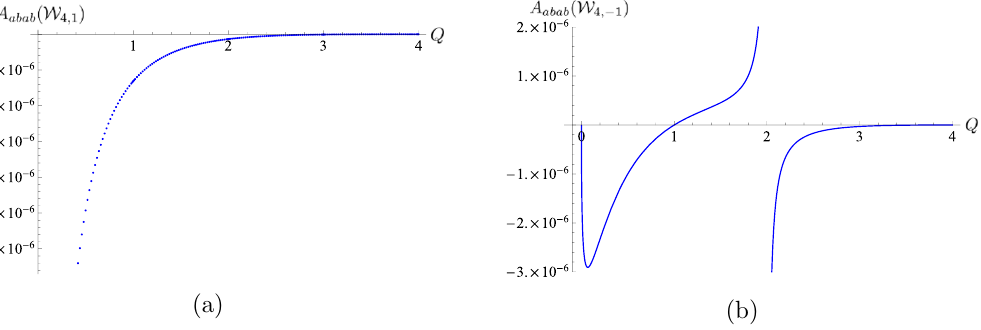
Figure 11 . The bootstrapped A abab ( W 4 , 1 ) on the left and the analytic A abab ( W 4 , − 1 ) on the right. The amplitudes A ( W ) and A ( W ) are shown in figure 10. They are smooth 2 , 1 2 , − 1 abab abab with no singularities in the whole range 0 < Q < 4